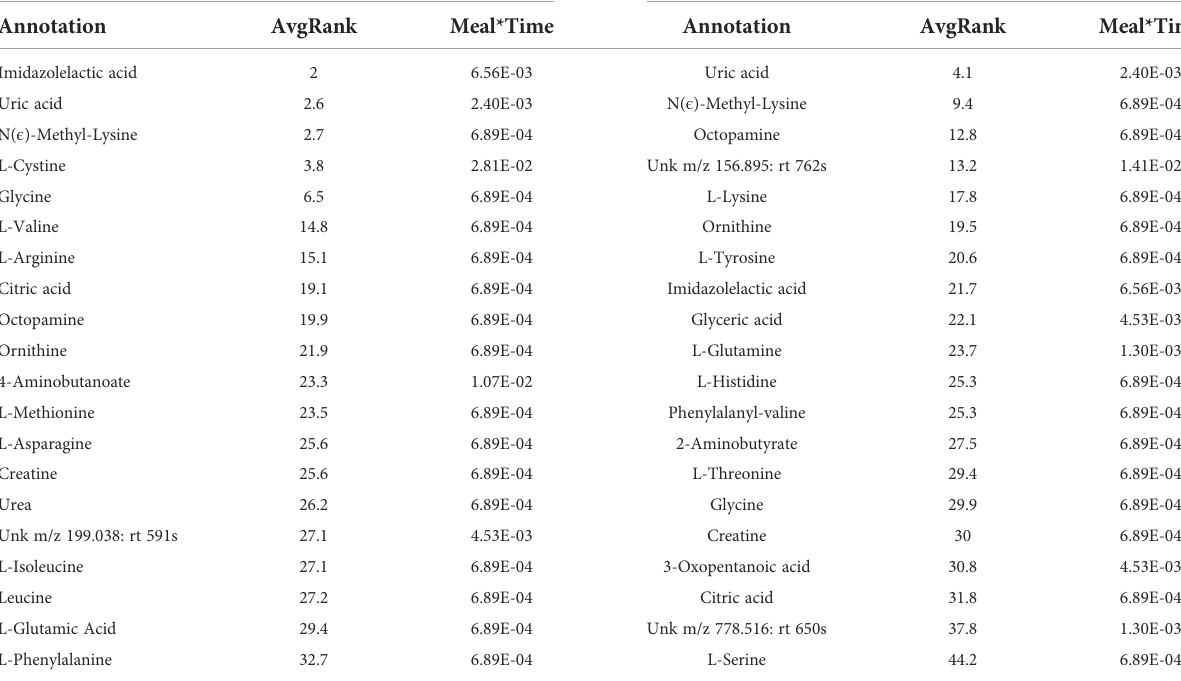
TABLE 2 Top 20 SVM-RFE metabolites for predicting ethnicity and IPFD models. Ethnicity